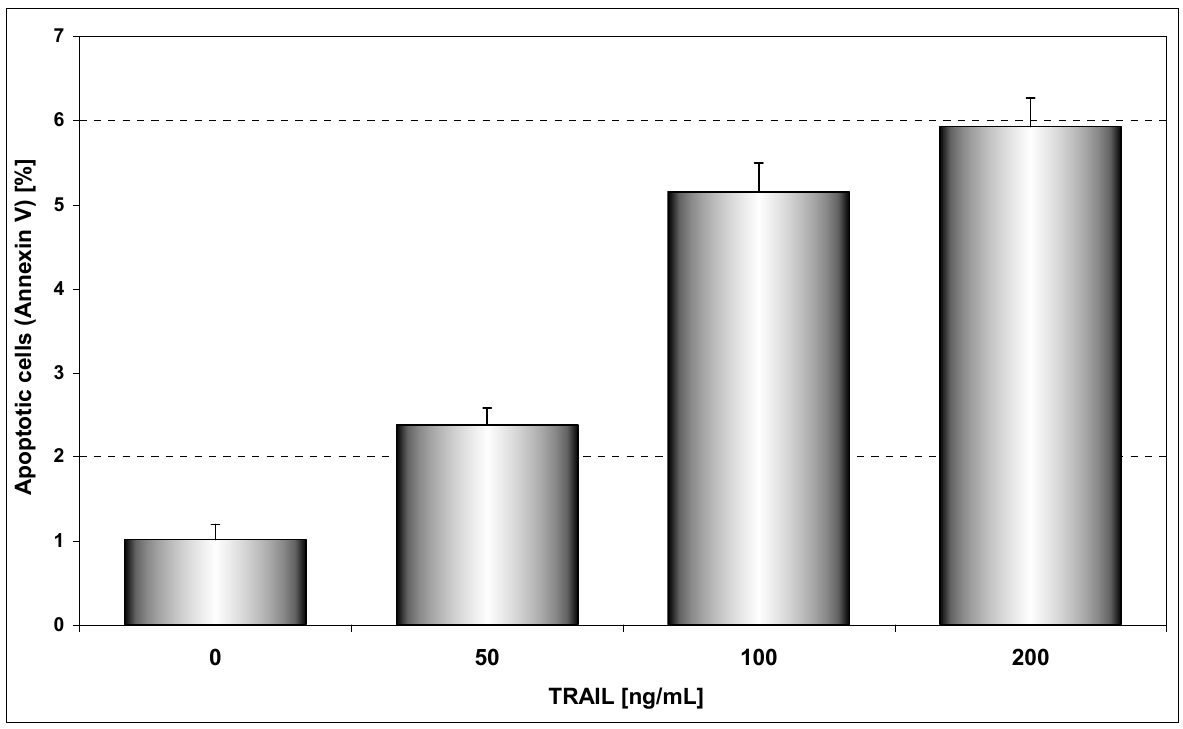
Figure 4. TRAIL induced apoptosis in HeLa cells. The cancer cells were incubated for 48 hours with TRAIL at the concentrations of 50 – 200 ng/mL. Detection of apoptotic cell death by annexin V-FITC staining using flow